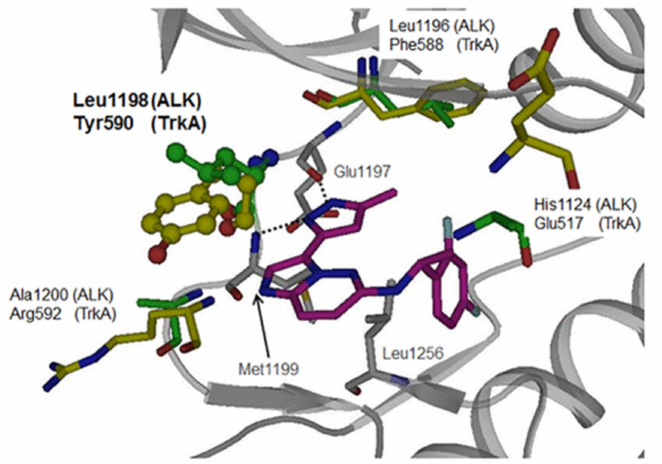
Figure 7. Structure of compound 3 .